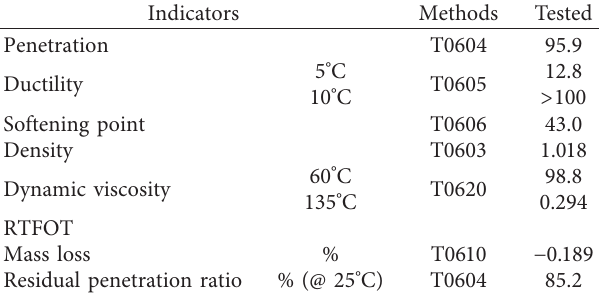
Table 2: Indicators of TiO